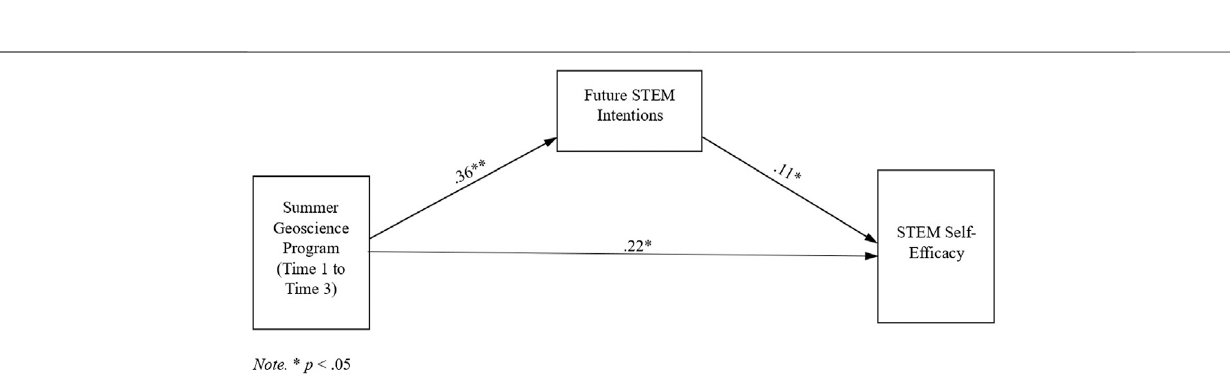
Frontiers in Education |